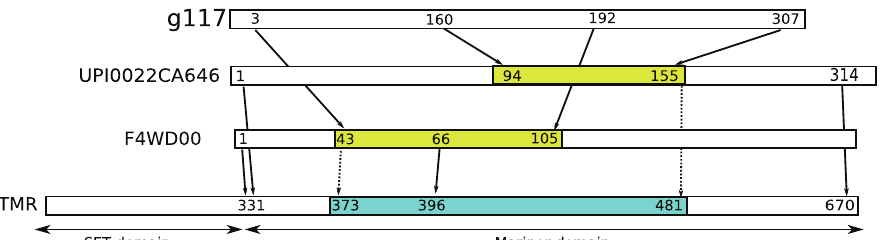
Figure 10. The g117 transcript had no significant BLASTX hits to SwissProt, nor any annotated Pfam domains. Again, by using hits against two UniRef 50 sequences, we can calculate a transitive alignment that covers the entire transcript sequence. Interestingly, the SETMR gene is primate specific, and consists of a Histone-lysine N-methyl transferase (SET domain, EC 2.1.1.43) with an inserted transposase (Hsmar1, EC 3.1), and it also has one isoform without the transposase. The transitive alignment of g117 is against the transposase domain, and the alignments of the intermediate proteins also match this part almost exactly, so in all likelihood, the SET domain is irrelevant for g117. Nevertheless, the annotation of F4WD00 in UniProt is as a methyl transferase. An annotation based on this would thus be incorrect, illustrating the dangers of using an uncurated database.